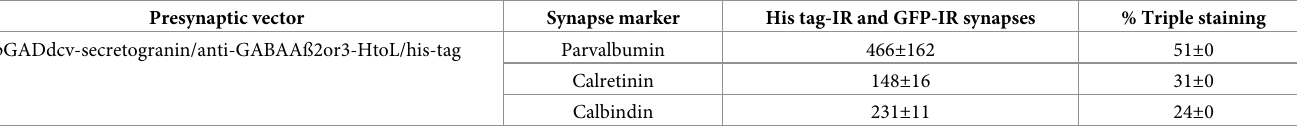
Table 3. GABAergic subtype markers in the connected postsynaptic neurons after gene transfer across GABA A ß2 or ß3-containing synapses. Presynaptic